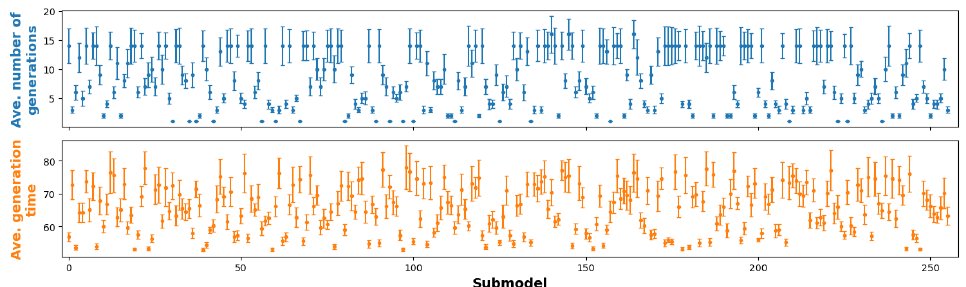
Figure 13: An example of the average number of generations (top) and generation time [s] (bottom) for all the 256 sub-models trained on ASCAD fixed sync . These values are obtained from across all ten folds to be trained. The error bars represent the Standard Error Mean (SEM) with 95% confidence interval.